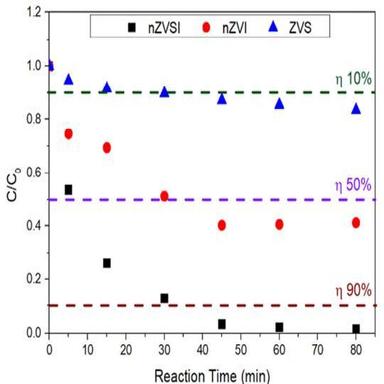
Evolution of BPB normalized concentration over time during the degradation with 0.8 g/L of nZVSI (triangles), nZVI (dots) and ZVS (squares); the dashed lines marks efficiency equal 10% (green line) 50% (violet line) and 90% (wine line).